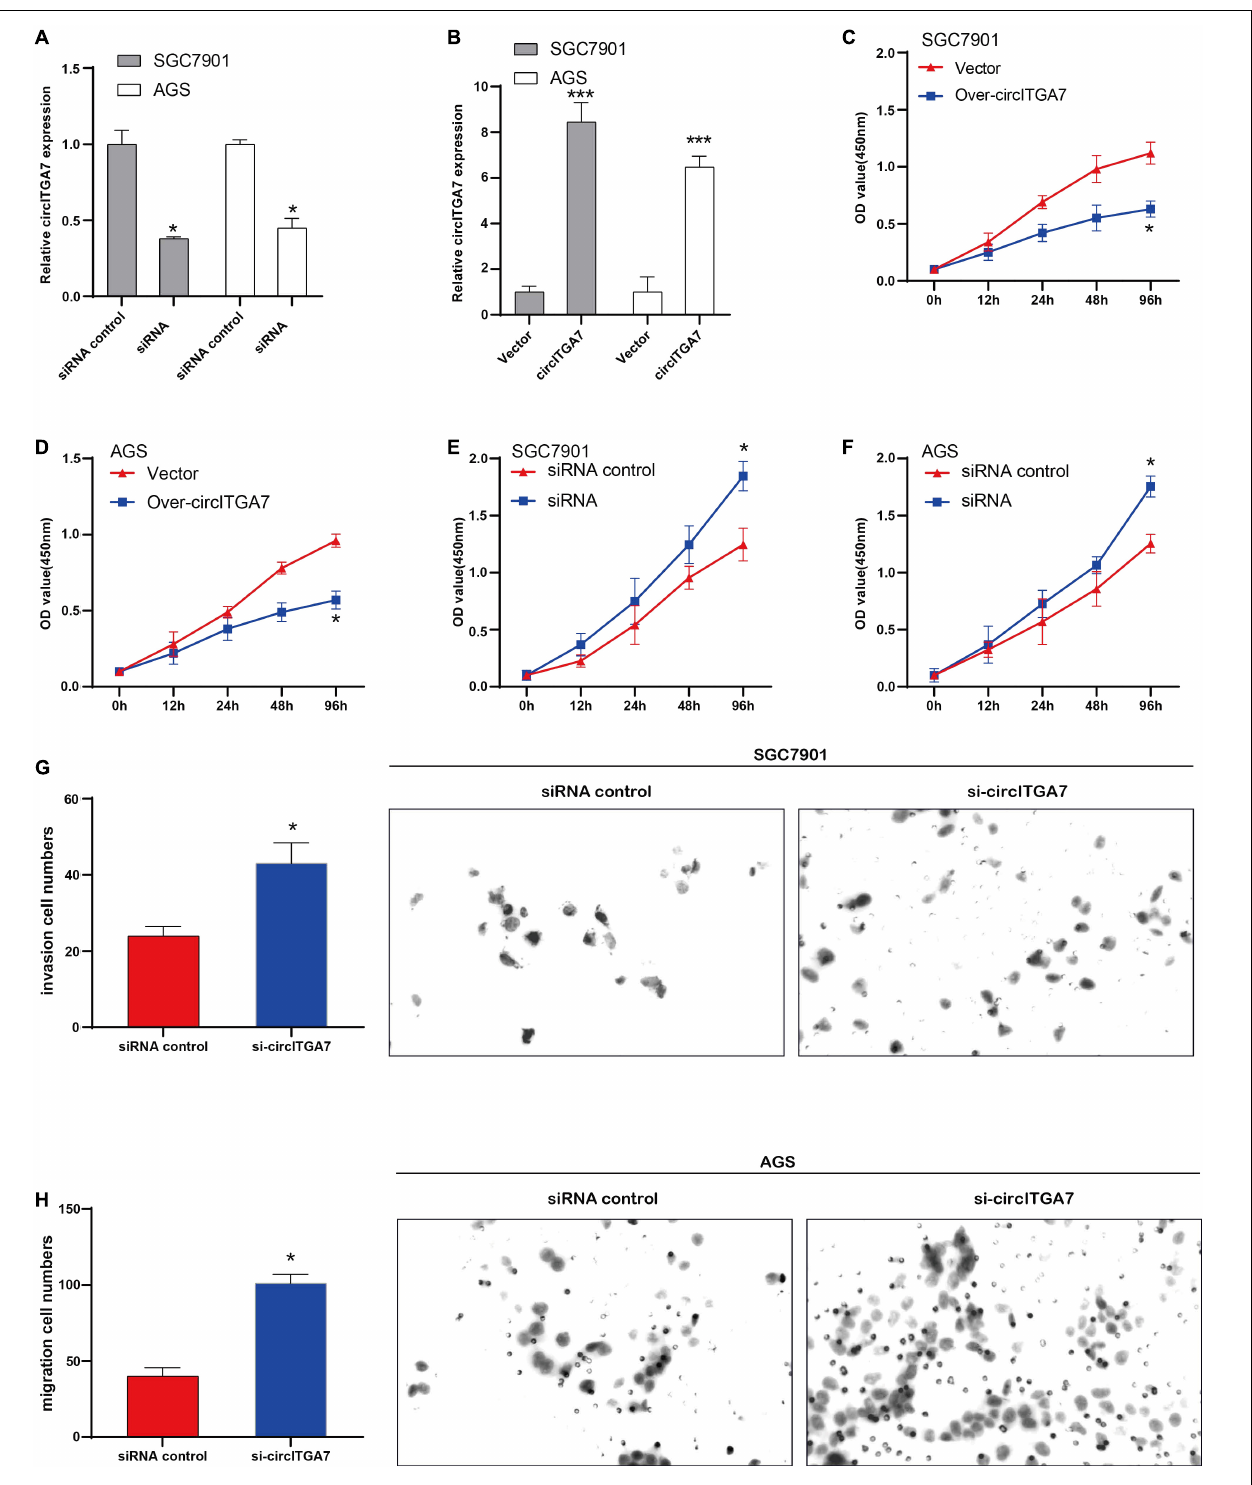
FIGURE 5 | CircITGA7 suppressed the development of GC in vitro . (A) The expressions of circITGA7 were remarkably downregulated in SGC7901 and AGS cells transfected with siRNA * P < 0.05. (B) The expressions of circITGA7 were remarkably upregulated in SGC7901 and AGS cells transfected with circITGA7 *** P < 0.001. (C,D) The cell proliferation in circITGA7-overexpressed SGC7901 and AGS cells was notably decreased * P < 0.05. (E,F) The cell proliferation in circITGA7 lowly expressed SGC7901 and AGS cells was notably decreased * P < 0.05. (G) The invasion ability in circITGA7 lowly expressed SGC7901 cells was significantly decreased. (H) The migration ability in circITGA7 lowly expressed AGS cells was significantly decreased.